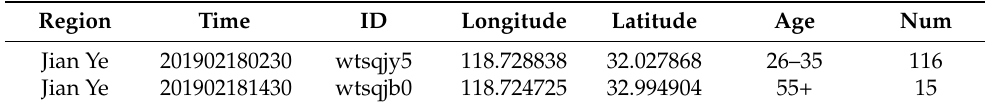
Table 1. The format of mobile subscriber